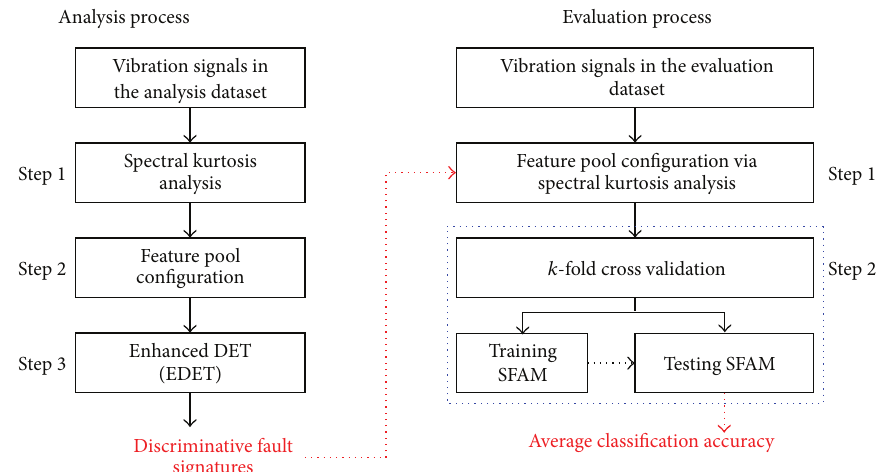
Figure 3: Overall process of the proposed comprehensive bearing fault diagnosis